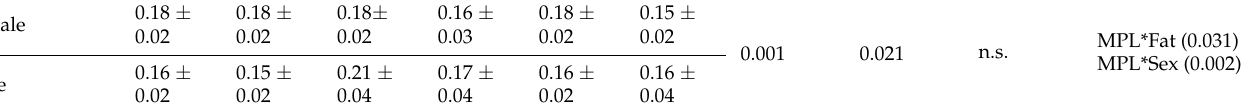
p -Value (Three-Way